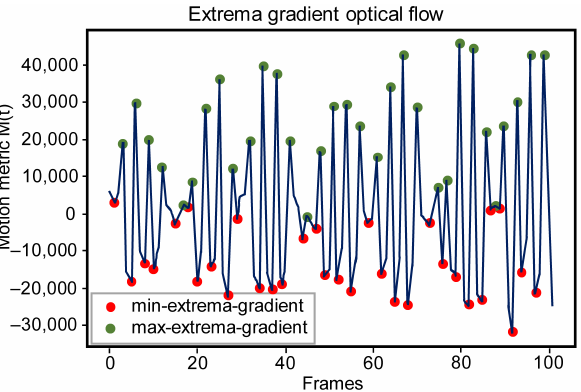
Figure 5. The gradient of the total motion metric for a walking video from the UCF Sports dataset. The red dots are the local minima, whereas the green dots are the local maxima of the gradient